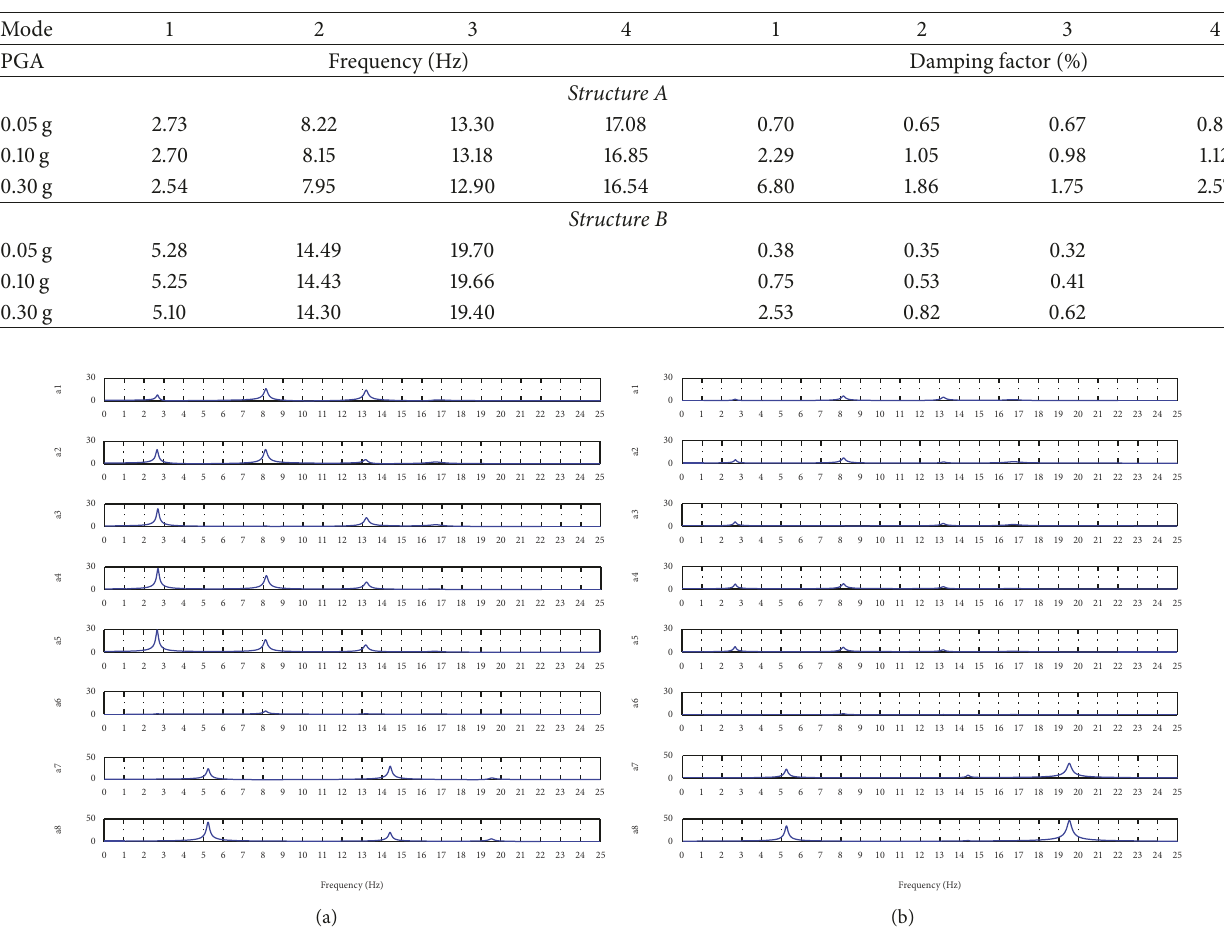
Figure 5: Nonconnected (NC) configuration, identified frequency response functions: (a) sensors a1–a8 versus ground acceleration 𝑥 direction; (b) sensors a1–a8 versus ground acceleration 𝑦 direction. White noise test PGA 0.1